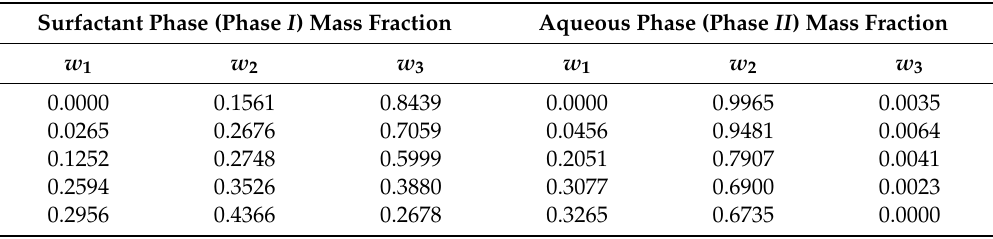
Figure 3. Experimental ternary phase liquid–liquid equilibria (tie-lines) for lactic acid + water + alcohol ethoxylate (AE) at T = 308.15 K and P = 0.1 MPa (atmospheric pressure). Table 2. Experimental tie-line data in mass fraction, w , for the ternary system containing lactic acid (1), water (2), and AE (3): T = 308.15 K and P = 0.1 MPa (atmospheric pressure) 1 .